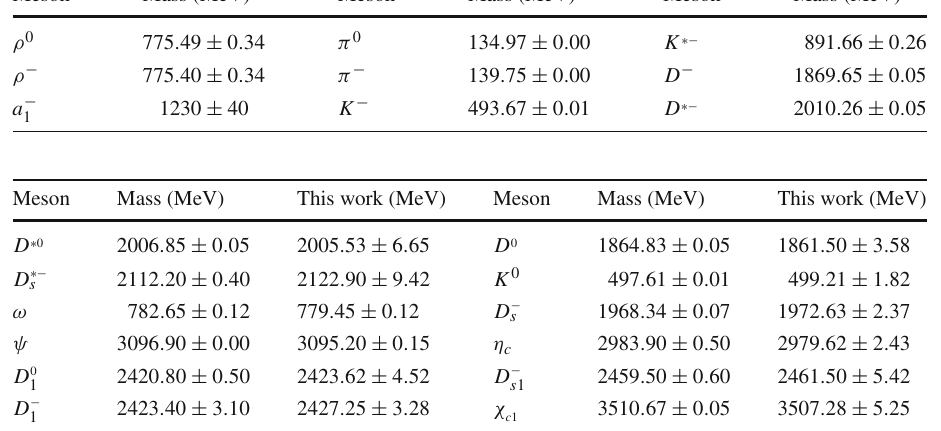
values of mass are used to fit z 0 , m u , d , s , c and σ u , d , s , c . These values are taken from [66]